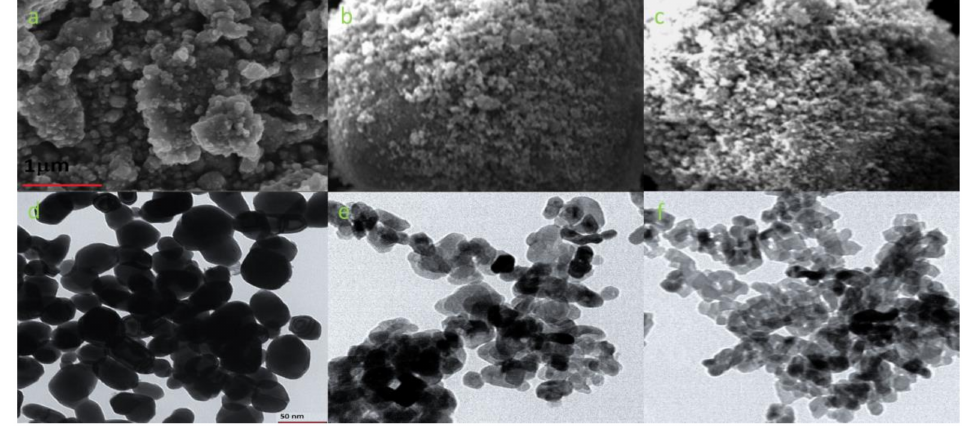
Figure 2. SEM images of S0 ( a ), S1 ( b ), S2 ( c ); TEM images of S0 ( d ), S1 ( e ), S2 ( f ).